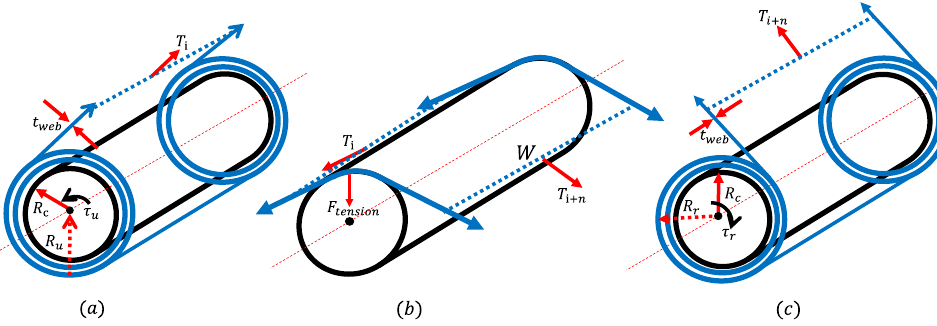
Figure 3. Schematic configuration of major components in the R2R system: ( a ) unwinder, ( b ) idle roller, and ( c )